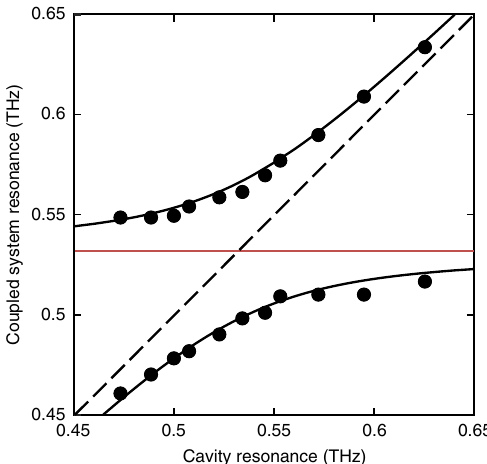
Fig. 5 THz vibro-polariton branches of strongly coupled α -lactose. The circles correspond to the measured polariton peaks, which were obtained by scanning the cavity resonance across the α -lactose absorption (marked by the horizontal red line). The dashed black line marks the empty cavity resonance while the solid black curves show the result of the coupled oscillator model (Eq. (1)) fi tted to the measured